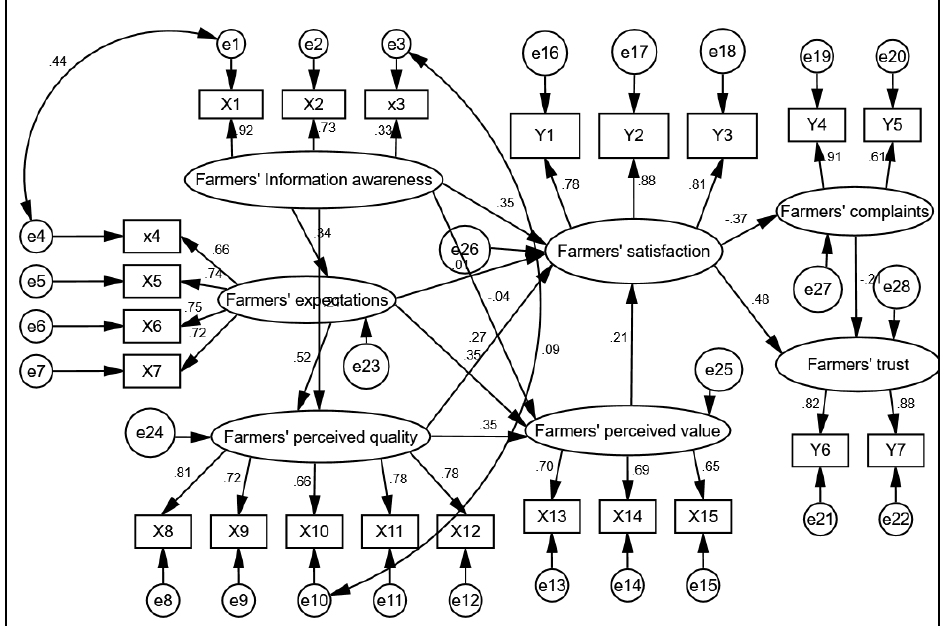
Figure 5. Modified farm household satisfaction model.